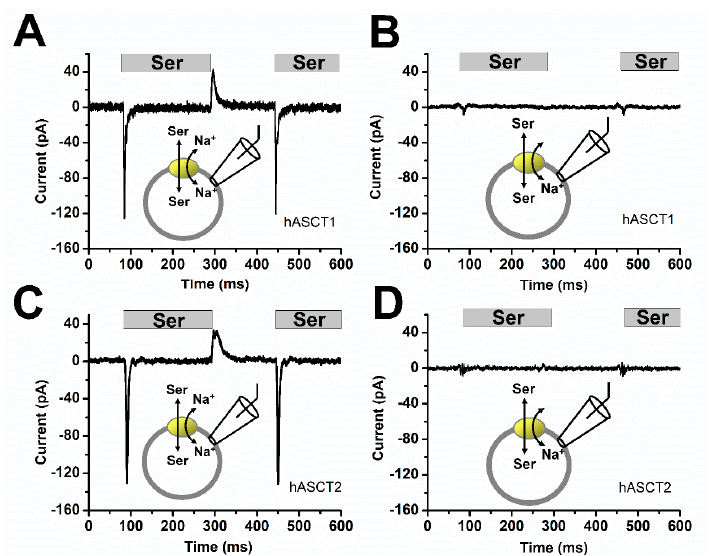
Figure 5. Rapid substrate application and removal induce capacitive-like transient currents in both ASCT1 and 2. ( A , C ) Typical current recording traces upon rapid solution exchange and removal using a θ tube. Experiments were performed with 140 mM Na + together with 500 µ M serine at the extracellular side, the intracellular solution contained 130 mM NaMes and 10 mM serine. Time constants for the decay of the transient current were τ 1 = 2.3 ± 0.1 ms for serine application and ± 0.2 ms for serine removal (ASCT1) and the charge movements Q τ 2 = 7.8 1 = 290 fC and Q 2 = 340 fC, respectively. For ASCT2 the time constants were τ 1 = 3.1 ± 0.1 ms and τ 2 = 11.4 ± 0.3 ms. ( B , D ) Similar experiments but in the absence of external Na +